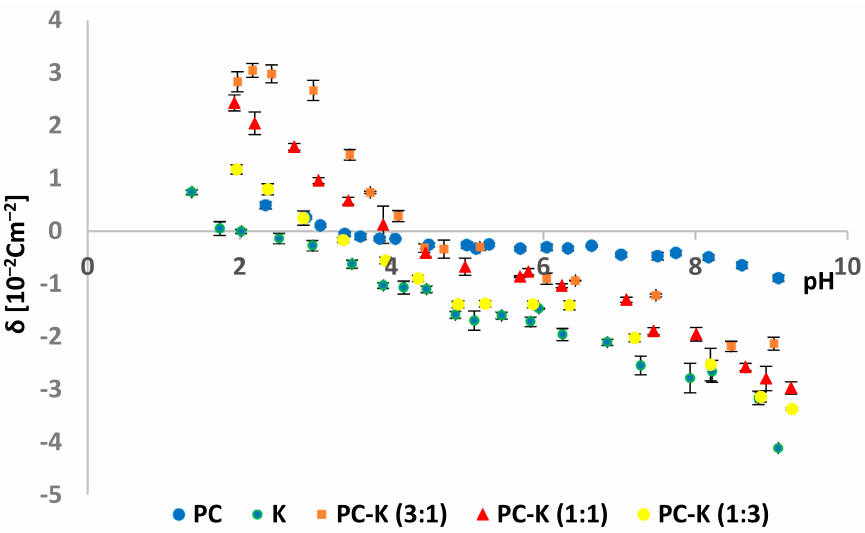
Figure 13. Dependence of PC and PC–K membrane surface charge densities vs. the pH of the electrolyte